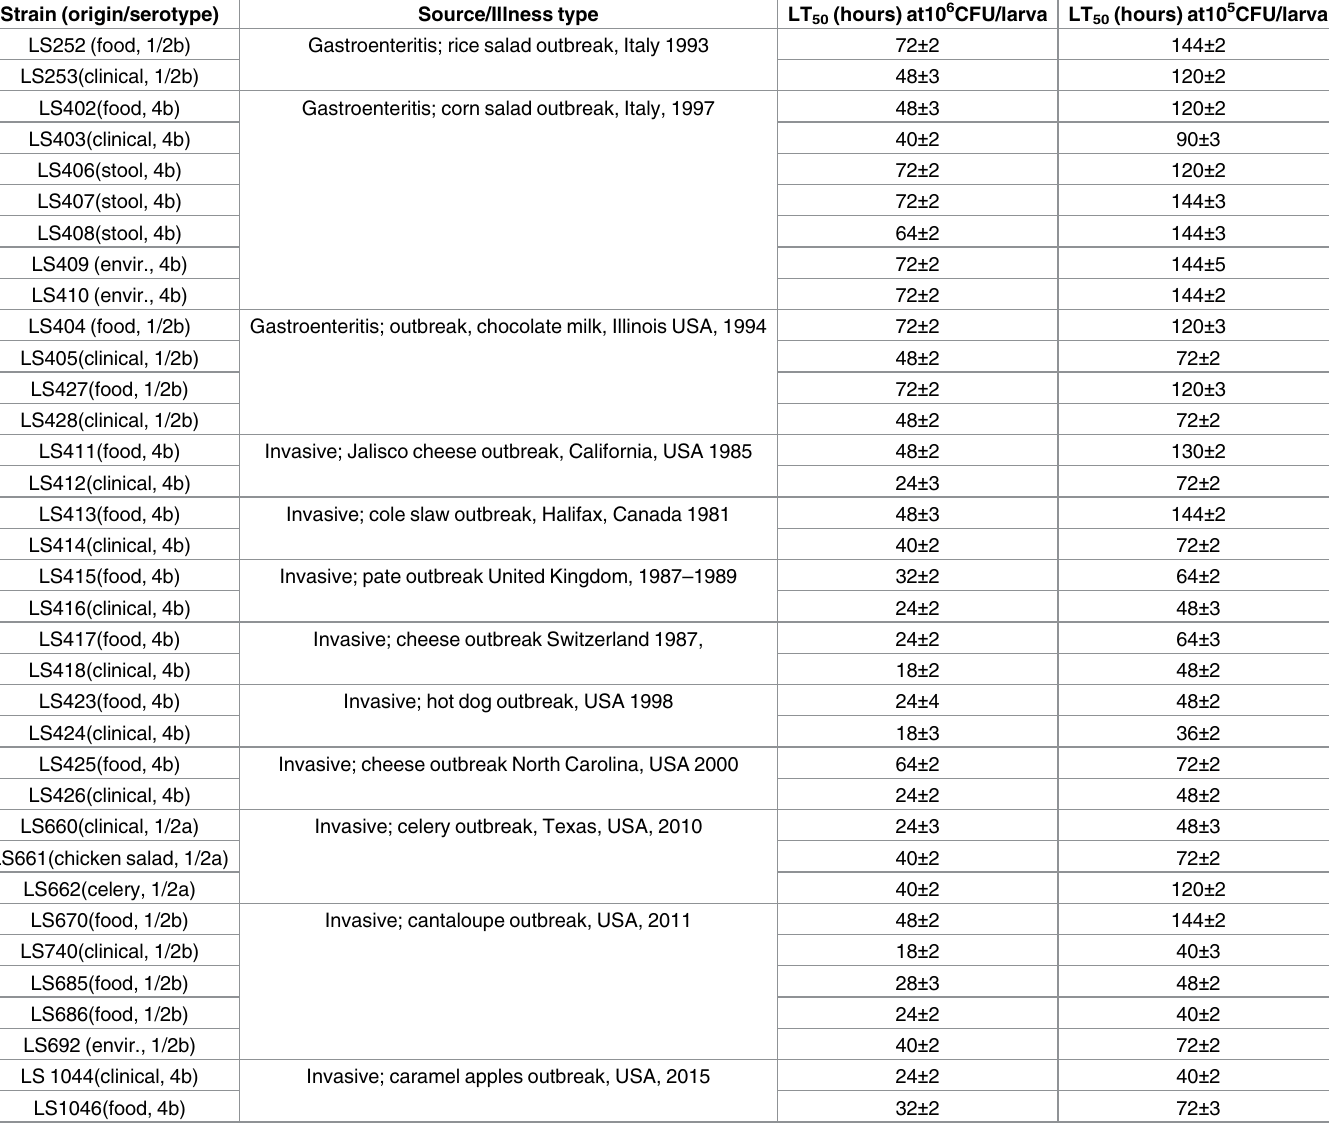
Table 4. LT 50 of G . mellonella larvae after inoculation with L . monocytogenes isolates * related to the major listeriosis outbreaks ** . Strain